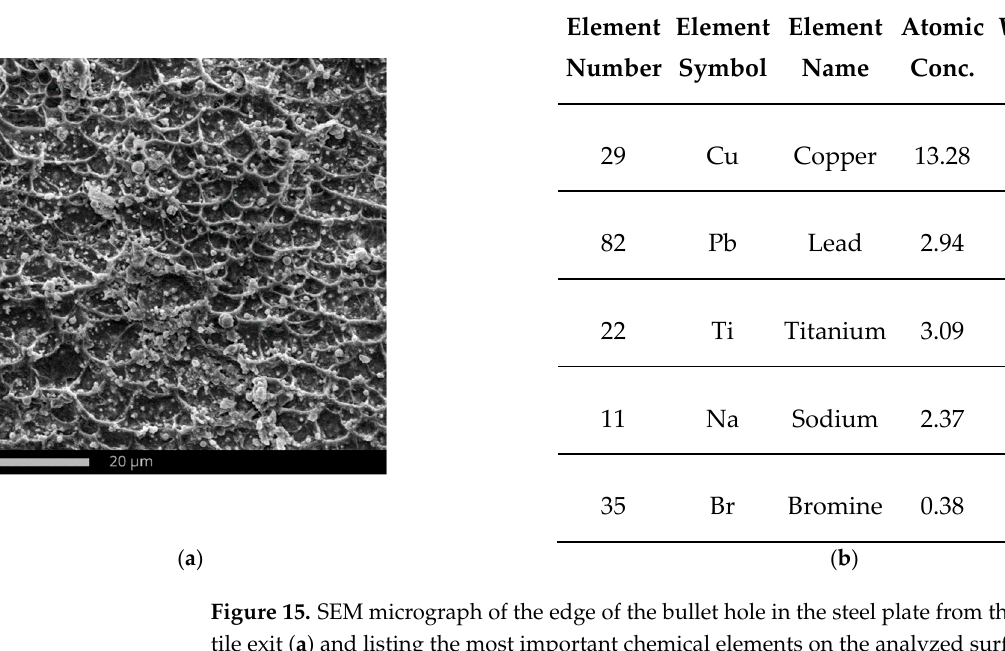
( b ) Figure 16. SEM micrograph of the edge of the bullet hole in the steel plate from the side of the projectile entry ( a ) and listing the most important chemical elements on the analyzed surface ( b ) determined by SEM ‐ EDS (FOV: 86.6 μ m, Mode: 15 kV—Image, Detector: SED). 4. Conclusions The movement of the projectile through a fluid ‐ filled bag creates a resistance force. The value of perforation resistance increases as the projectile speed decreases. Field tests have shown that the presence of glycol ‐ filled bag increases the perforation resistance of the structure, which is also confirmed by numerical models. The FEM ‐ SPH method